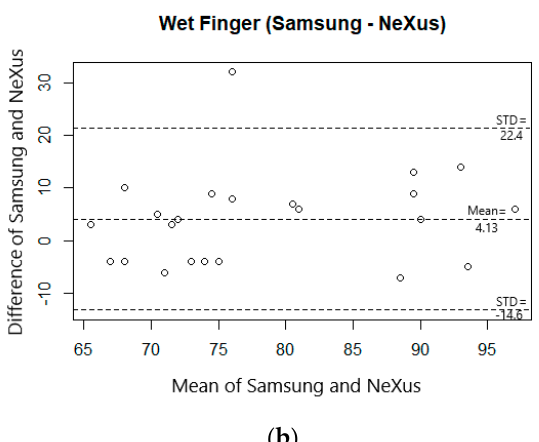
Figure 9. Bland–Altman plots of heart rate measurements after signal processing. ( a ) Heart rate from Samsung Galaxy Note8 and NeXus-10 MKII in dry environment, and ( b ) Heart rate from NeXus-10 MKII in dry and Samsung Galaxy Note8 in wet environment.